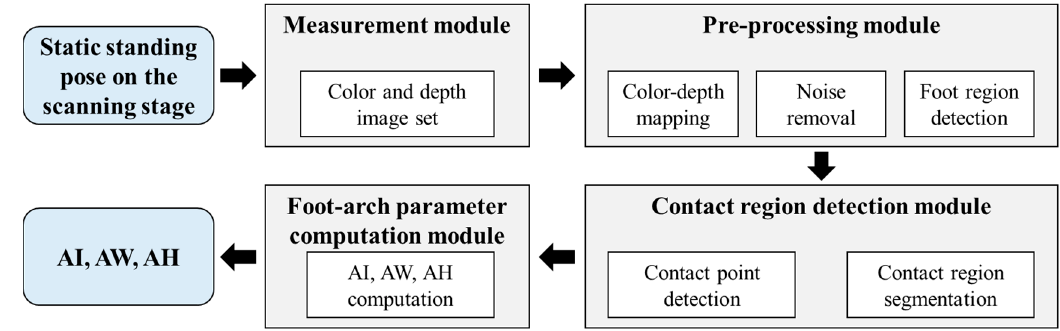
Figure 2. System flow of the proposed system.